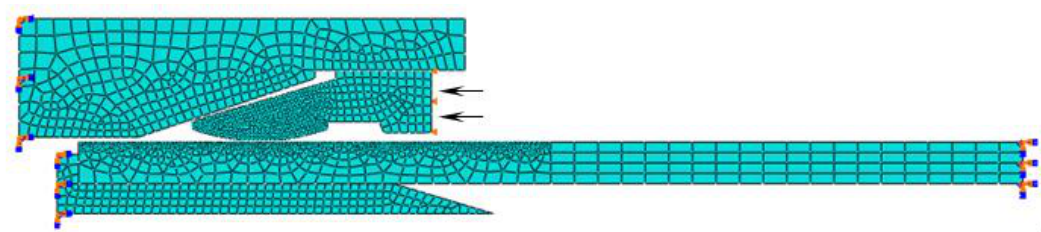
Figure 5. Description of the finite element (FE) model.